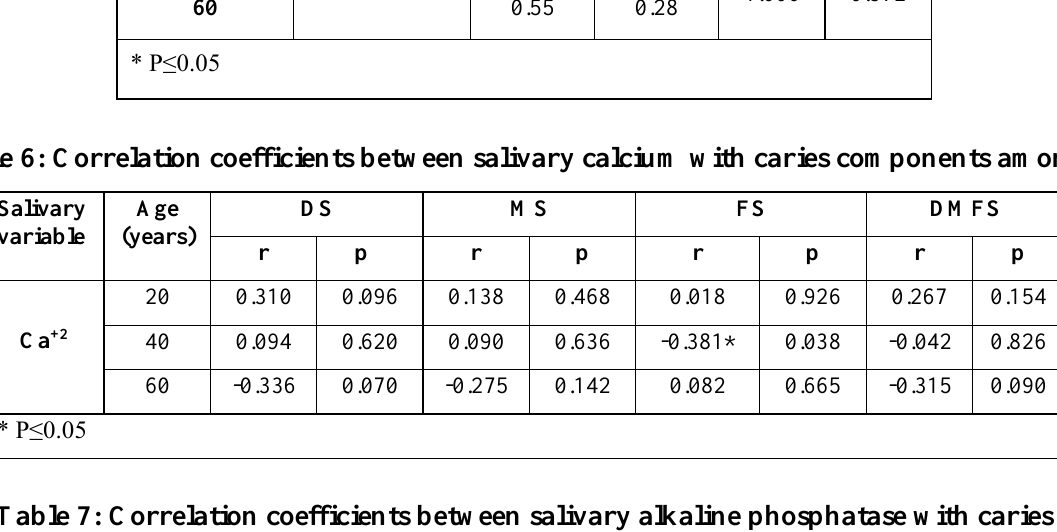
Table 7: Correlation coefficients between salivary alkaline phosphatase with caries components among ages Salivary